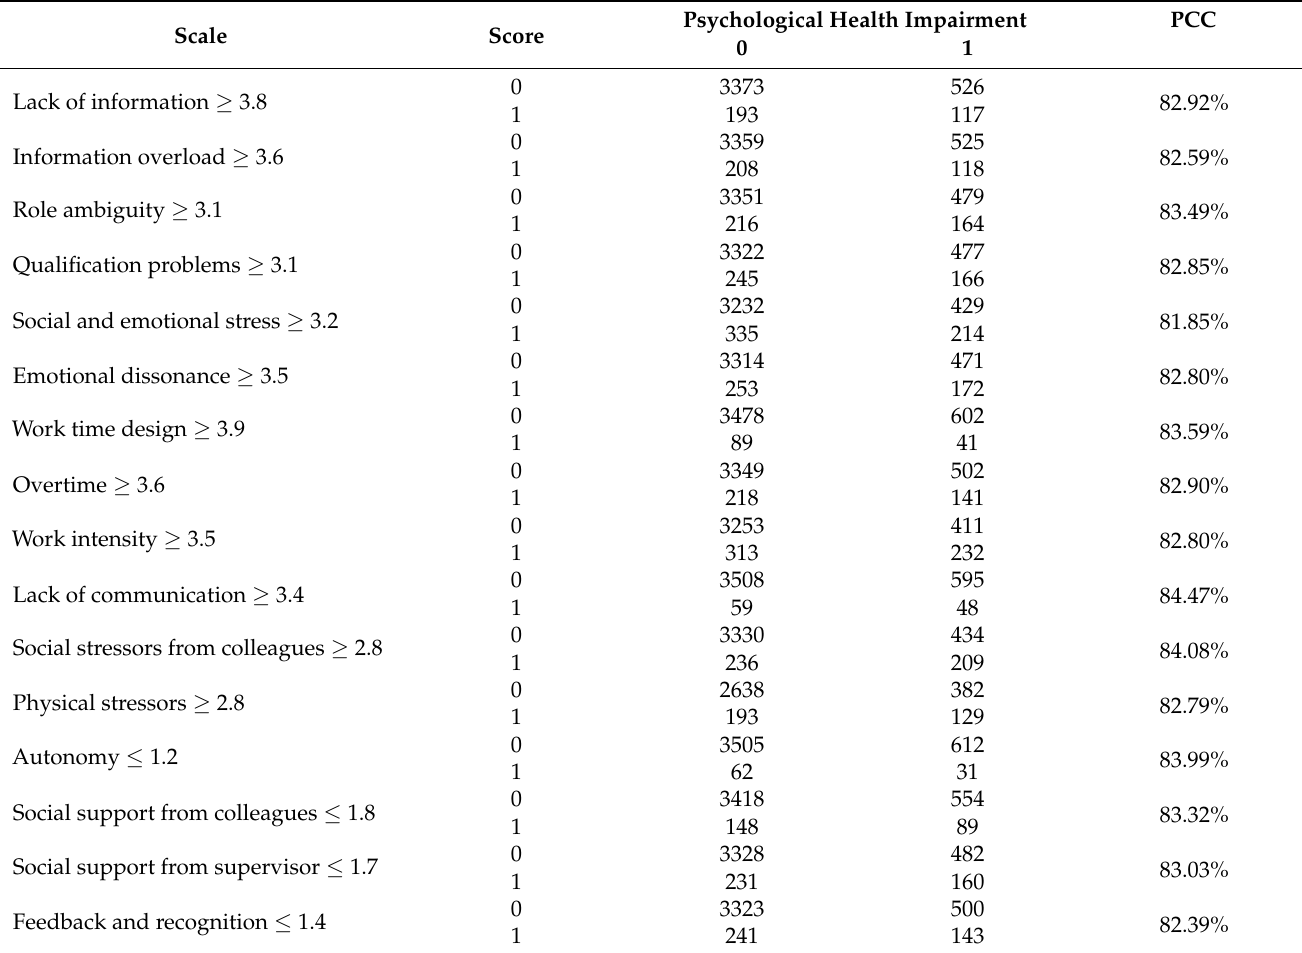
Table 5. Cross tables and percent correct classifications